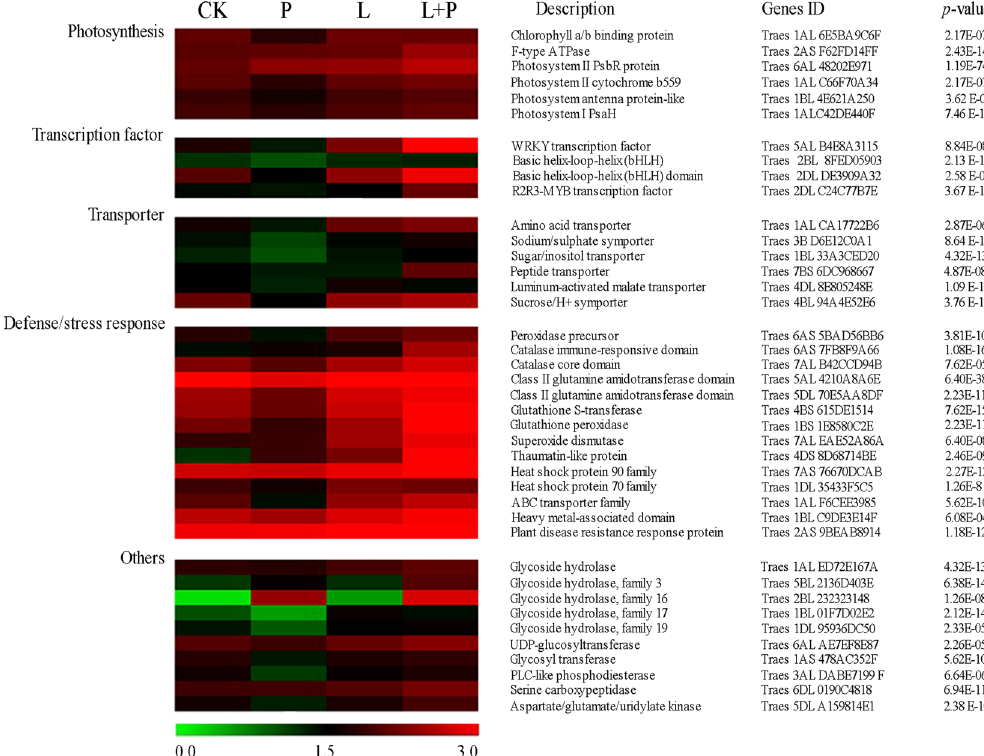
Figure 5. Expression profile of 40 differentially expressed genes involved in transcription regulation, photosynthesis, transport, defense/stress response, and others in He-Ne laser pretreated wheat seedlings under drought stress. The bar represents the scale of the expression levels for each gene (log 10 RPKM (number of reads per kilobase per million clean reads)) in the different treatments as indicated by red/green rectangles. Genes in red indicate up-regulation and in green indicate down-regulation. All genes in this list have a P -value for differential expression < 10 − 5 . The control (CK), natural drought stress (P), 3 min laser radiation (L), 3 min laser radiation + natural drought stress (L + P). Complete information for each gene list can be found in Table